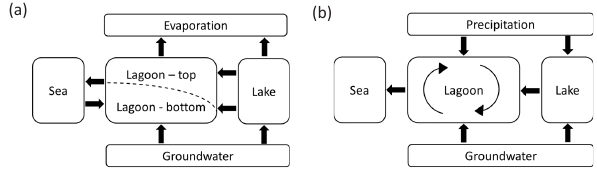
Figure 3. Conceptual model of flow connections between the la- goon and surrounding water bodies for (a) the dry and (b) wet sea-